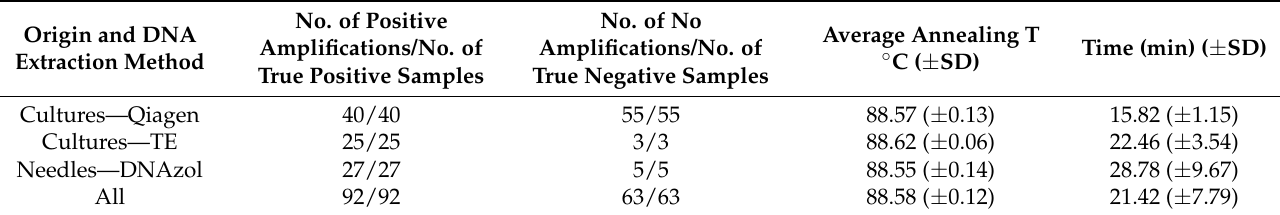
Table 2. Summary LAMP results based on amplification of template DNA extracted from pure cultures and needles. Cultures—Qiagen indicates results for DNA extracted using the Qiagen method and Cultures—TE indicates the results for DNA extracted using the TE